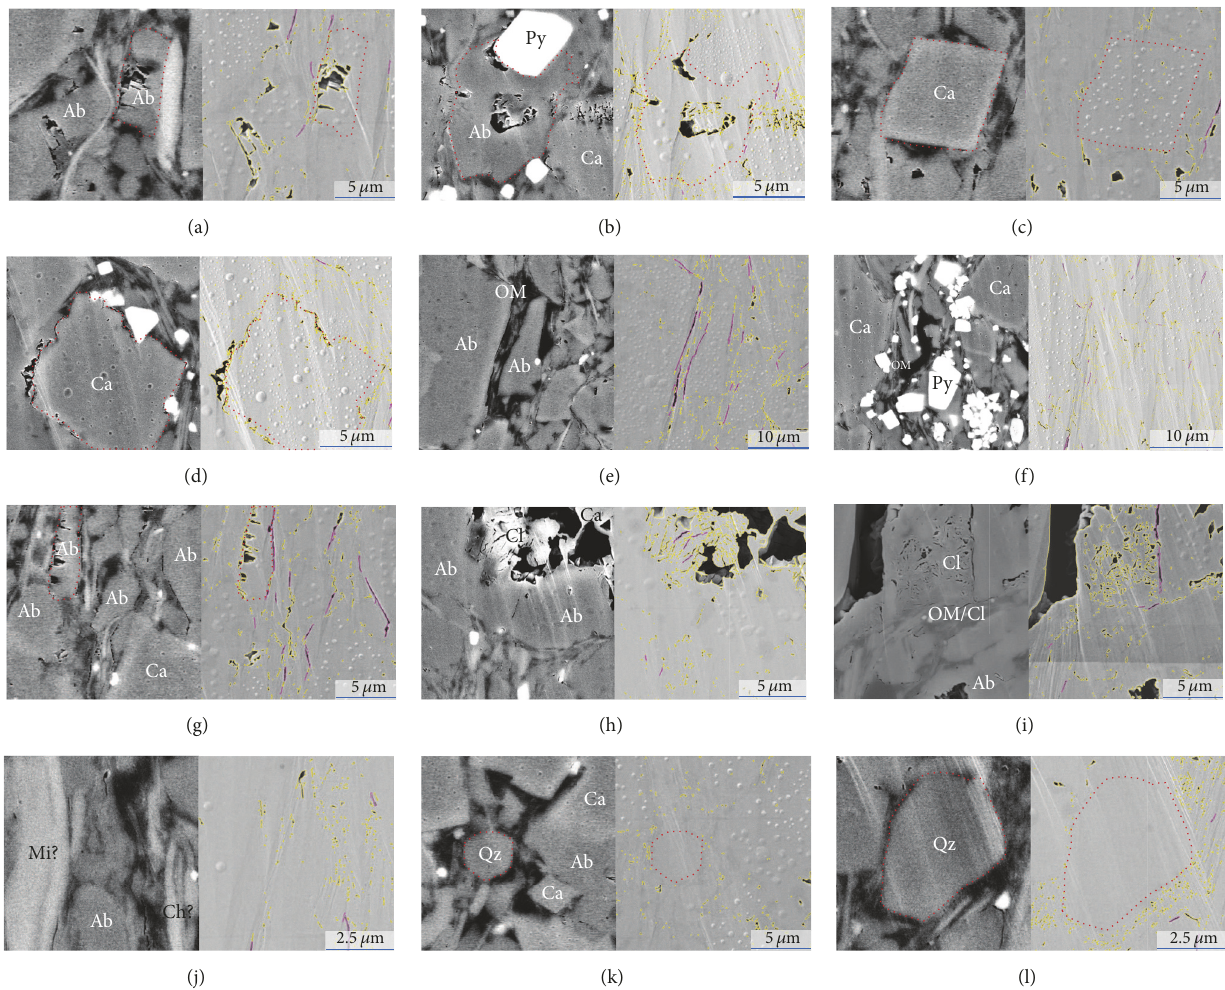
Figure 2: Mineralogical, microstructural, and morphological features of clasts (red), pore space (yellow/purple), and rock matrix showing BSE (a, c, e, g, i, k) and SE2 (b, d, f, h, j, l) recordings of sample NJ-001. Grains occur in a wide range of sizes but were chosen according to their characteristic properties for this illustration (e.g., due to partial idiomorphism). Porosity is predominantly distributed between clastsand OM interfaces ( InterP ), representing very narrow elongated slits along grain boundary interfaces within the polycrystalline matrix. Minerals phases are as follows: Ab, albite; Ca, carbonate; Ch, chlorite; Cl, clay; Fs, feldspar; Mi, mica; OM, organic matter; Py, pyrite; Qz, quartz.